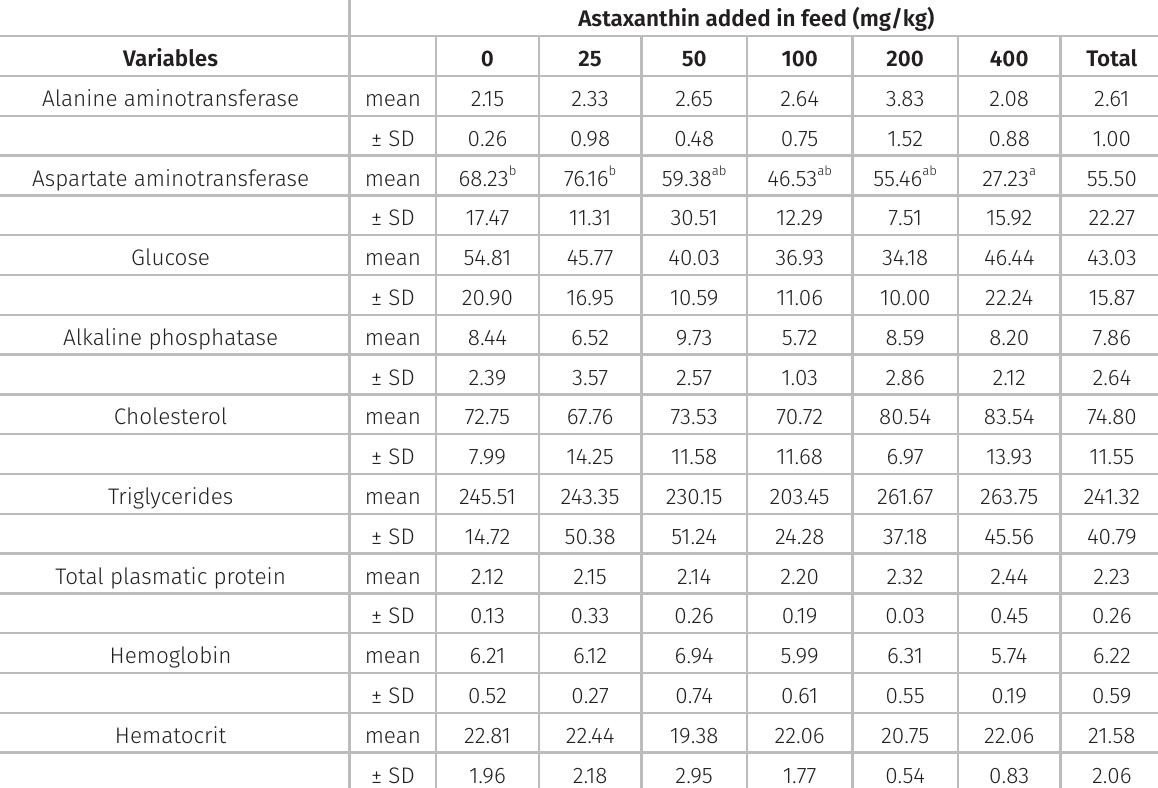
Table II. Blood parameters in juvenile L. alexandri feed by diets with different levels of synthetic astaxanthin. Variables Alanine aminotransferase